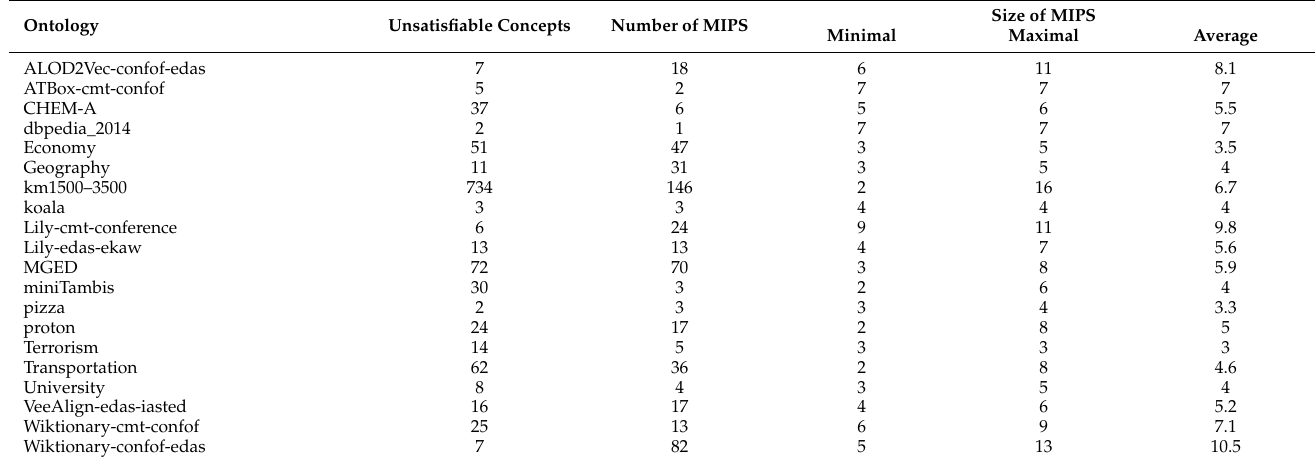
Table 3. Information about MIPS in all selected